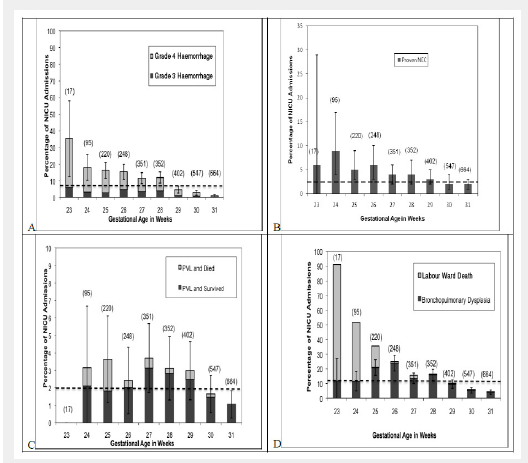
A: Age stratified rates of intraventricular haemorrhage. Overall rate of severe IVH is 8%. B: Age stratified rates of periventricular leukomalacia. Overall rate of PVL is 2%. C: Age stratified rates of necrotizing enterocolitis. Overall NEC rate is 3%. D: Age stratified rates of moderate/severe bronchopulmonary dysplasia. Overall BPD rate is 11.0%. Confidence intervals are shown by the error bar. Absolute number of NICU admissions is indicated by the N in (). Overall rates are shown by the dashed